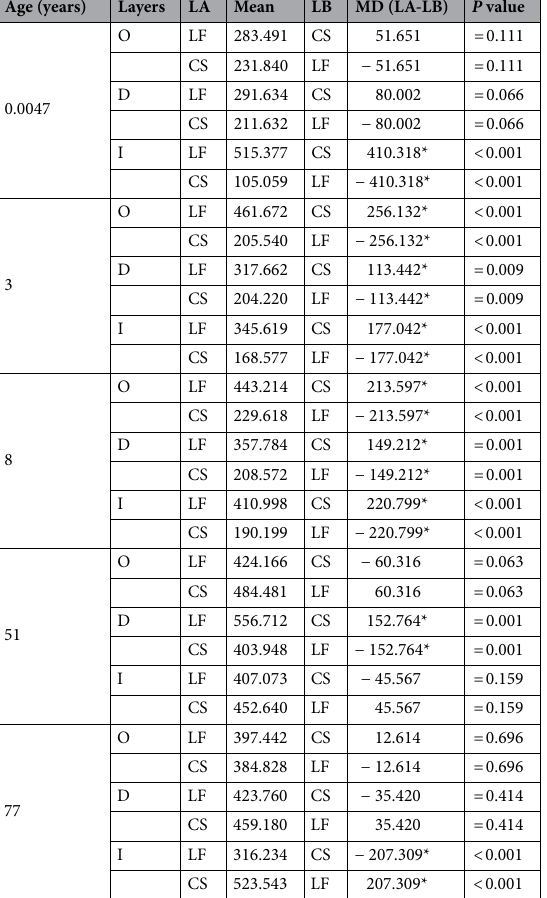
Table 6. HIT comparison among different locations. MD: mean different; LA: location A; LB: location B; *: significant differences (Table 7 are the